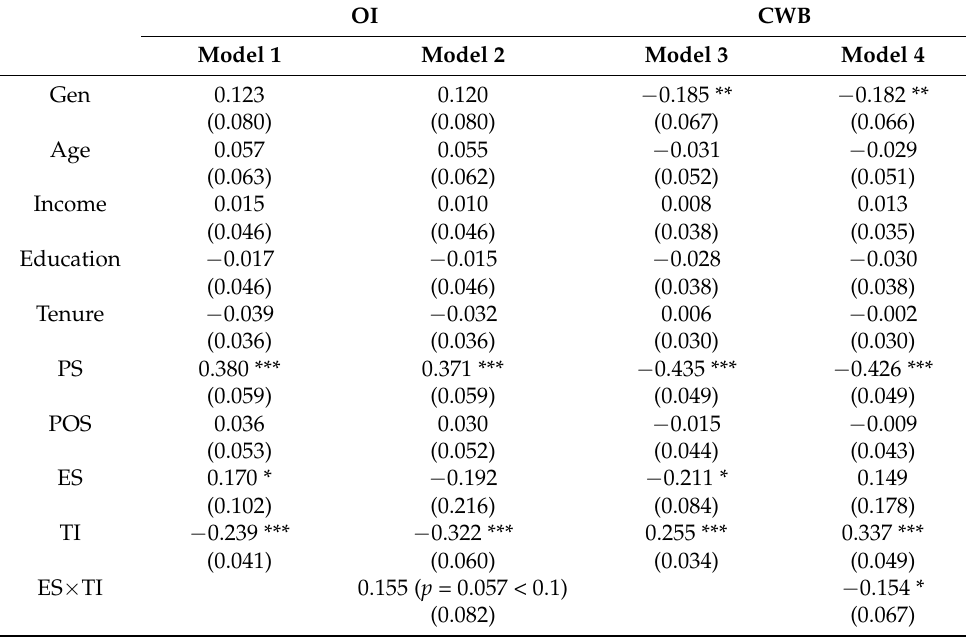
Table 5. Moderating effects of employment status.